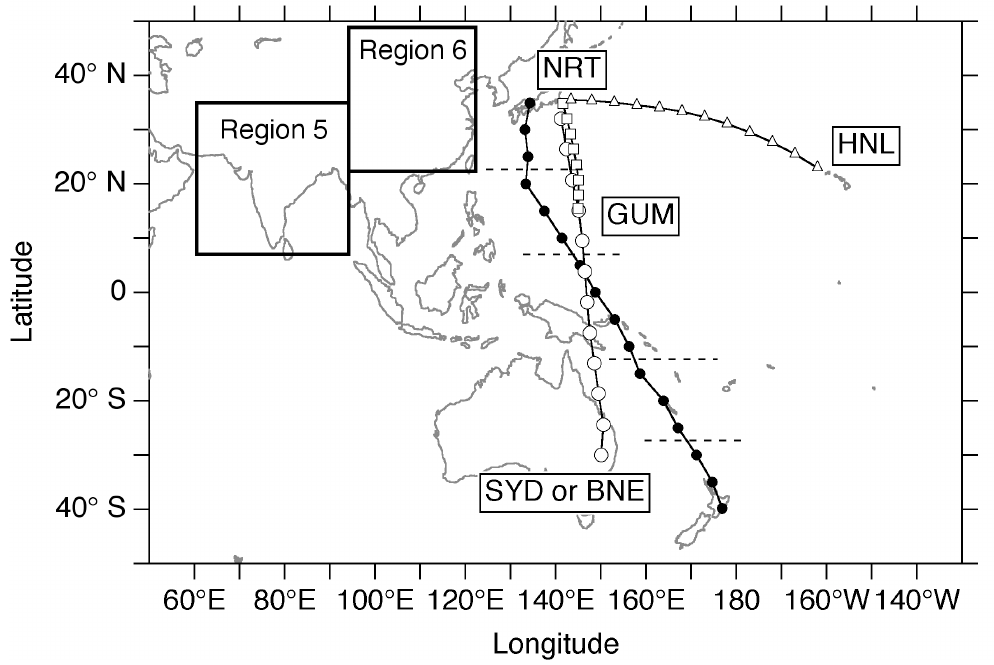
Fig. 1. A map showing locations where air samples were collected in this study. NRT: Narita, GUM: Guam, HNL: Honolulu, SYD: Sydney, BNE: Brisbane. The air sampling was made between NRT and SYD or BNE for December 2005–March 2009 (open circles), between NRT and GUM for April 2009–March 2010 (open squares) and between NRT and HNL for April–September 2010 (open triangles). Also shown are air sampling locations by container ships (closed circles). Dashed lines on the ship track represent the division of latitude bands for the data analysis (see text). Boxes denote the two regions (Region 5 and Region 6) assigned for the tagged experiments.